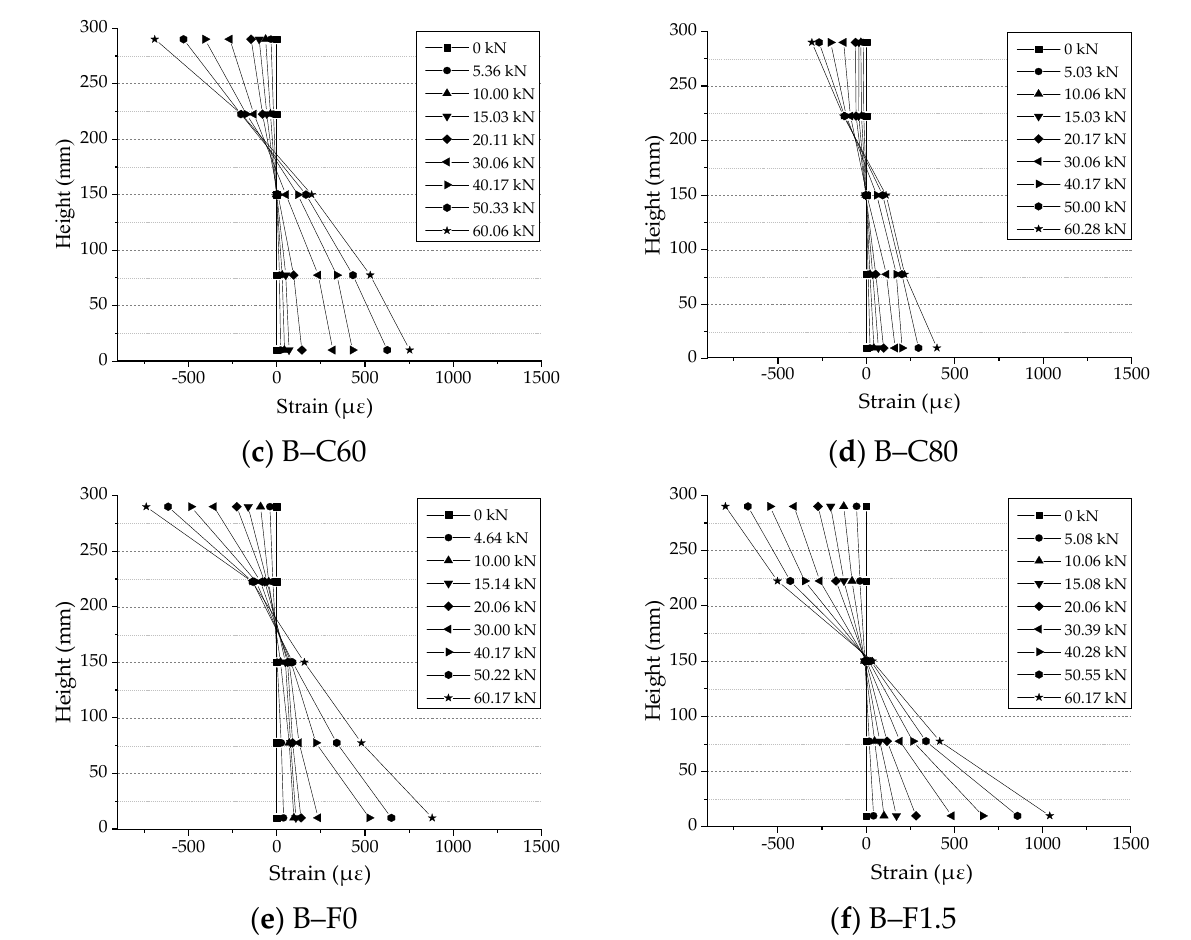
Figure 8. The strain of concrete along the height of the cross-section: ( a ) B–RC, ( b ) B–C40F1S1, ( c ) B–C60, ( d ) B–C80, ( e ) B–F0, ( f ) B–F1.5.